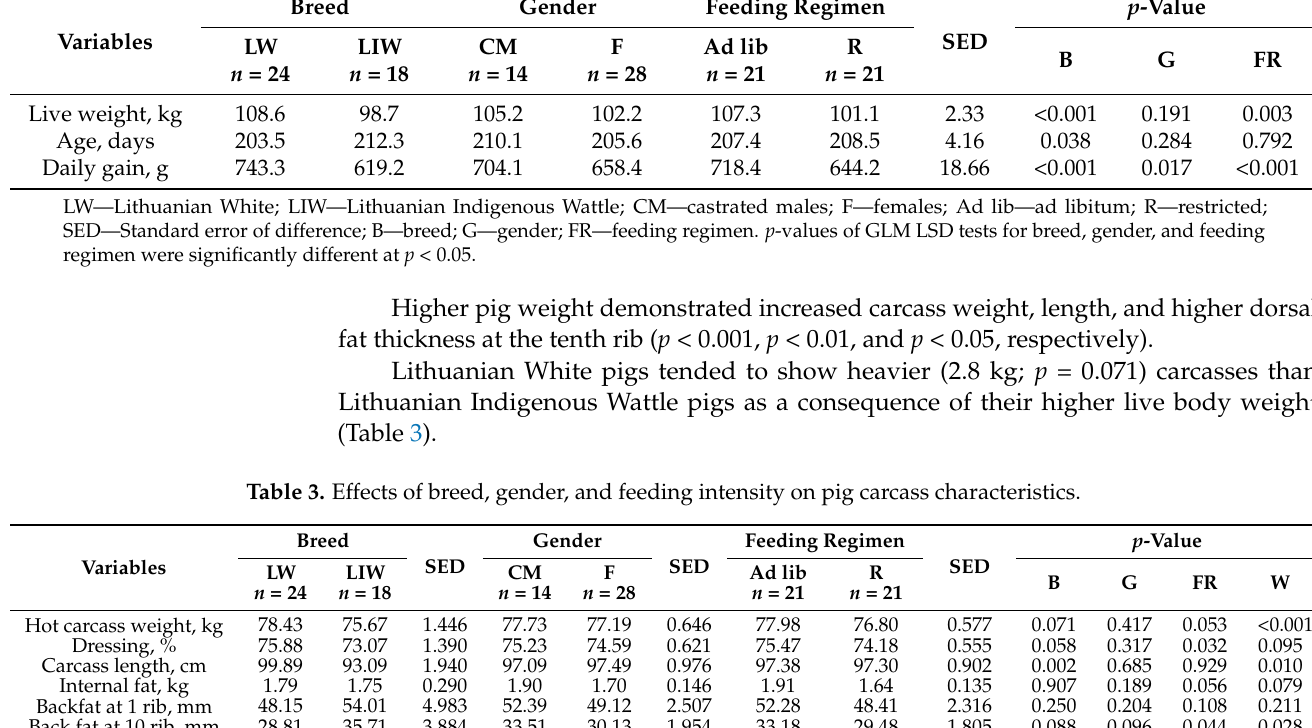
LW—Lithuanian White; LIW—Lithuanian Indigenous Wattle; CM—castrated males; F—females; Ad lib—ad libitum; R—restricted; SED—Standard error of difference; B—breed; G—gender; FR—feeding regimen; W—weight. p values of GLM LSD tests for breed, gender, and feeding regimen were significantly different at p <